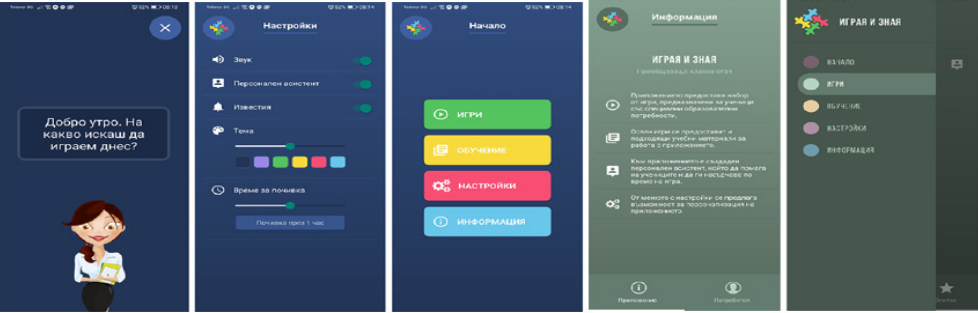
Figure 12. User interface—mobile application (in Bulgarian).